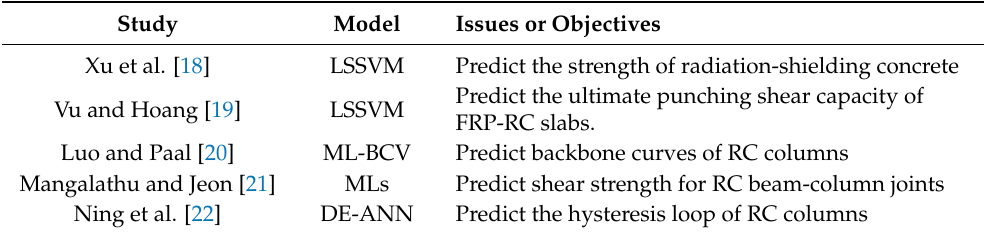
Table 1. Application of machine learning in the study of RC structures. Study Model Issues or Objectives Xu et al. [18] LSSVM Predict the strength of radiation-shielding concrete Predict the ultimate punching shear capacity of Vu and Hoang [19] LSSVM FRP-RC slabs. Luo and Paal [20] ML-BCV Predict backbone curves of RC columns Mangalathu and Jeon [21] MLs Predict shear strength for RC beam-column joints Ning et al. [22] DE-ANN Predict the hysteresis loop of RC